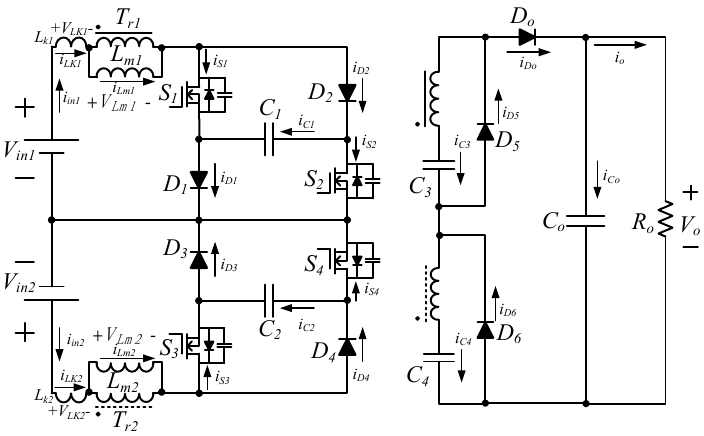
Figure 2. Equivalent circuit of the proposed converter.